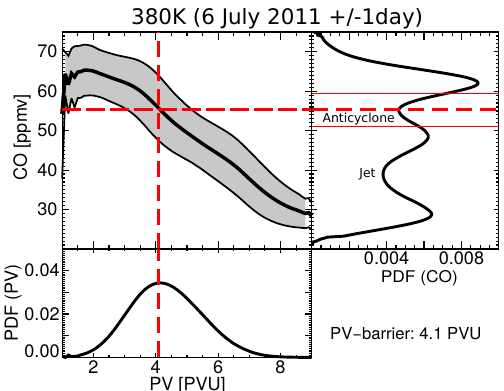
Figure A1. Asian monsoon transport barrier at 380K on 6 July 2011 from the CO mixing ratio PDF. The main panel (upper left) shows CLaMS CO (monsoon region average, 5–7 July time aver- age) vs. PV with one standard deviation as grey shading. The up- per right panel shows the corresponding mixing ratio PDF with the monsoon transport barrier highlighted as red dashed line. The lower panel shows the PDF of PV-values around the barrier (between the thin red lines in the upper right panel). (See text for further